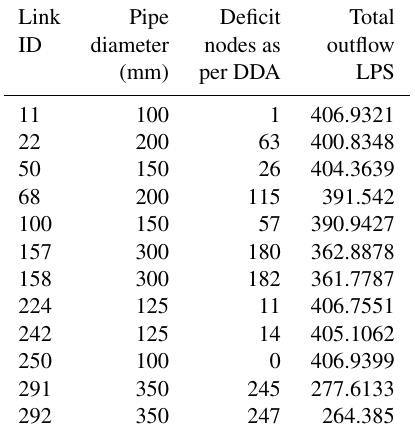
Table 8. Total outflow from Modena-network-selected links’ isola- tion